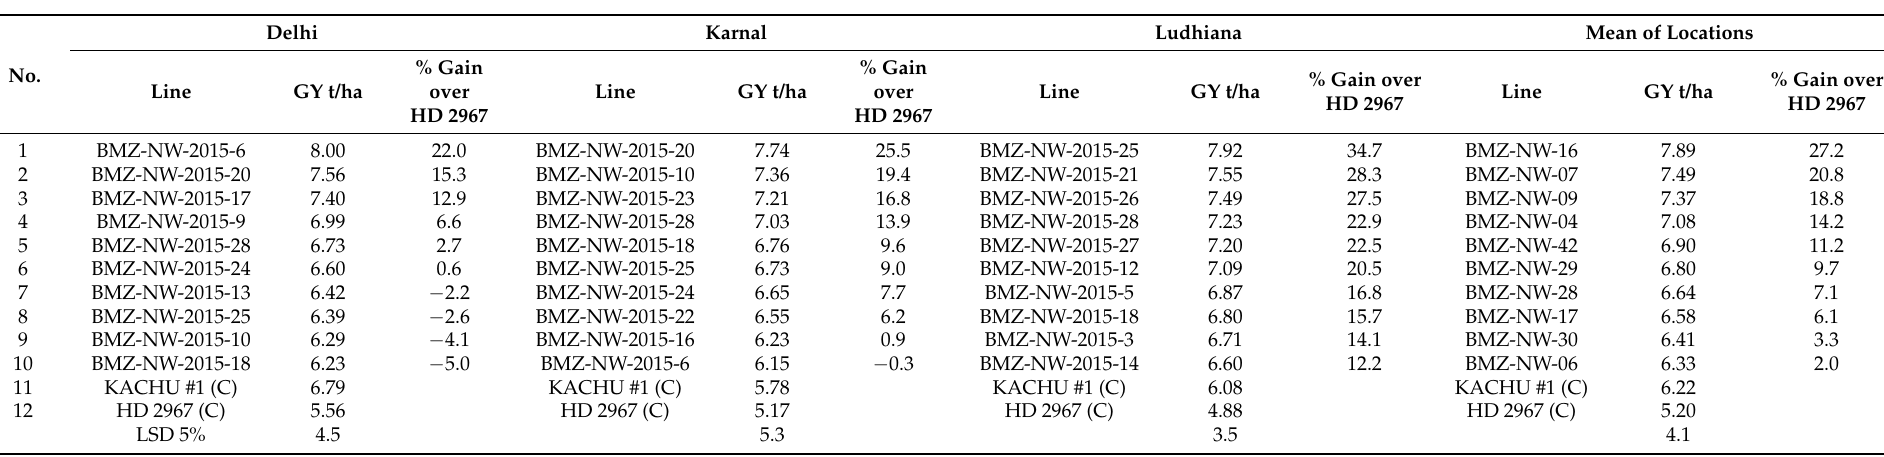
Table 7. Performance of genotypes for grain yield under early sowing in 2014–2015 in three locations of the North West Plains Zone of